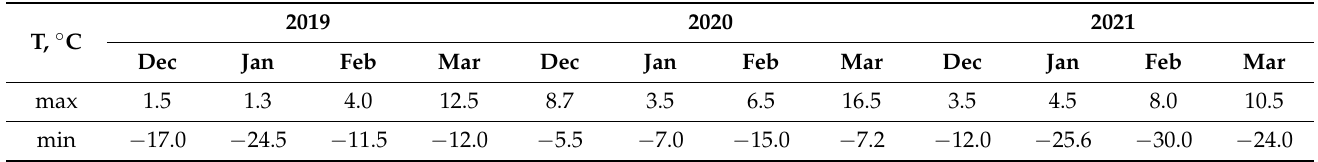
Table 1. Air temperature in autumn